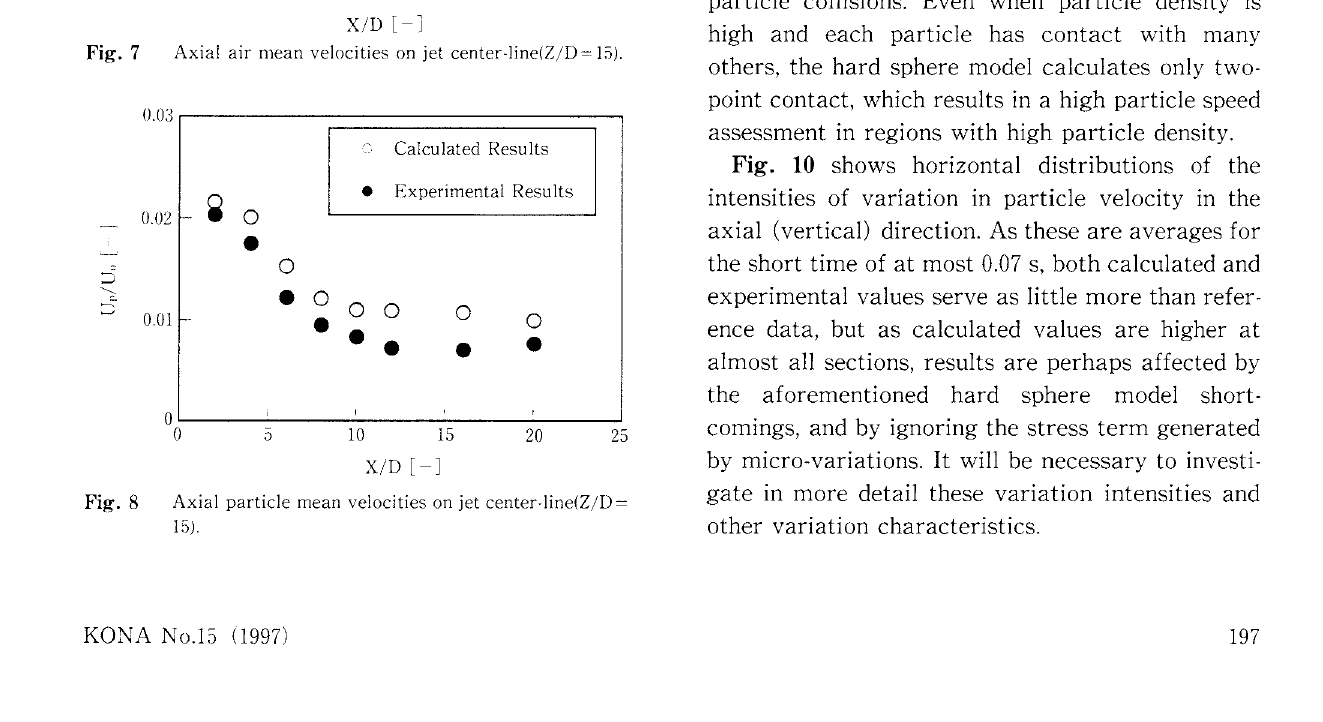
Axial air mean velocities on jet center-line(Z/D= 15).